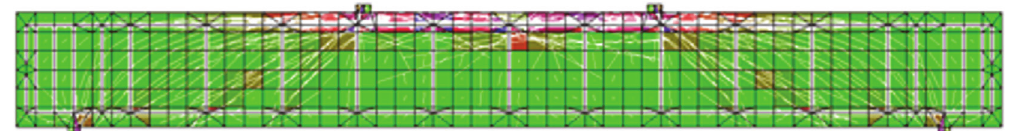
Figure 14: Typical stress flow at shear failure modes of beams B7-B8 (VecTor2 analysis).